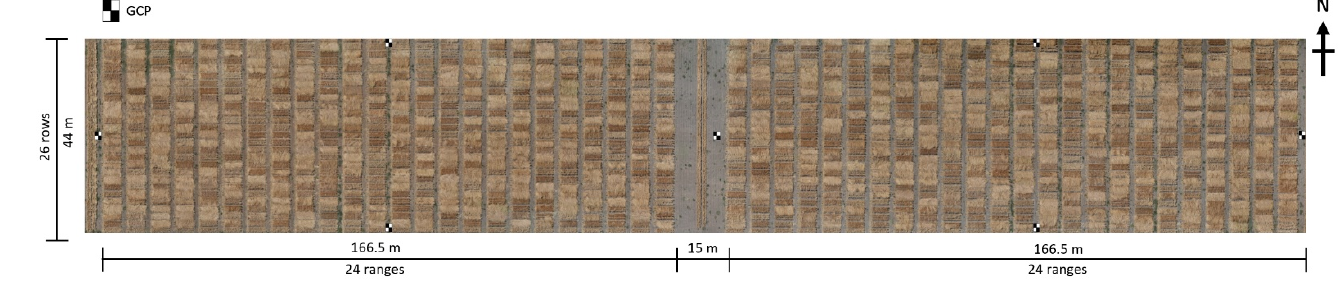
Figure 2. Wheat field experiment. Ground control points (GCPs) indicated in figure.